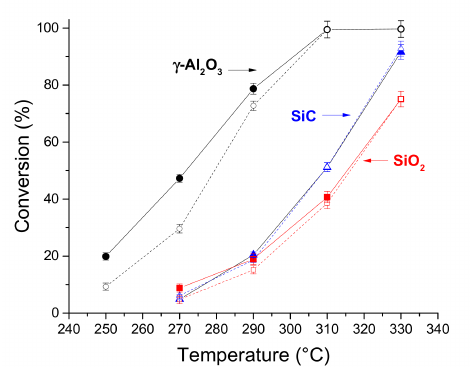
Figure 4. Effect of temperature on the conversions of methyl palmitate (solid symbols, solid lines) and oxygen-containing compounds (empty symbols, dash lines) over Ni 2 P/SiO 2 –SiC (triangles), Ni 2 P/SiO 2 –SiO 2 (squares) and Ni 2 P/SiO 2 – γ -Al 2 O 3 (circles) systems. Reaction conditions: P H —3.0 MPa, H 2 /feed—600 Nm 3 /m 3 , weight hourly space velocity (WHSV)—5 h − 1 2